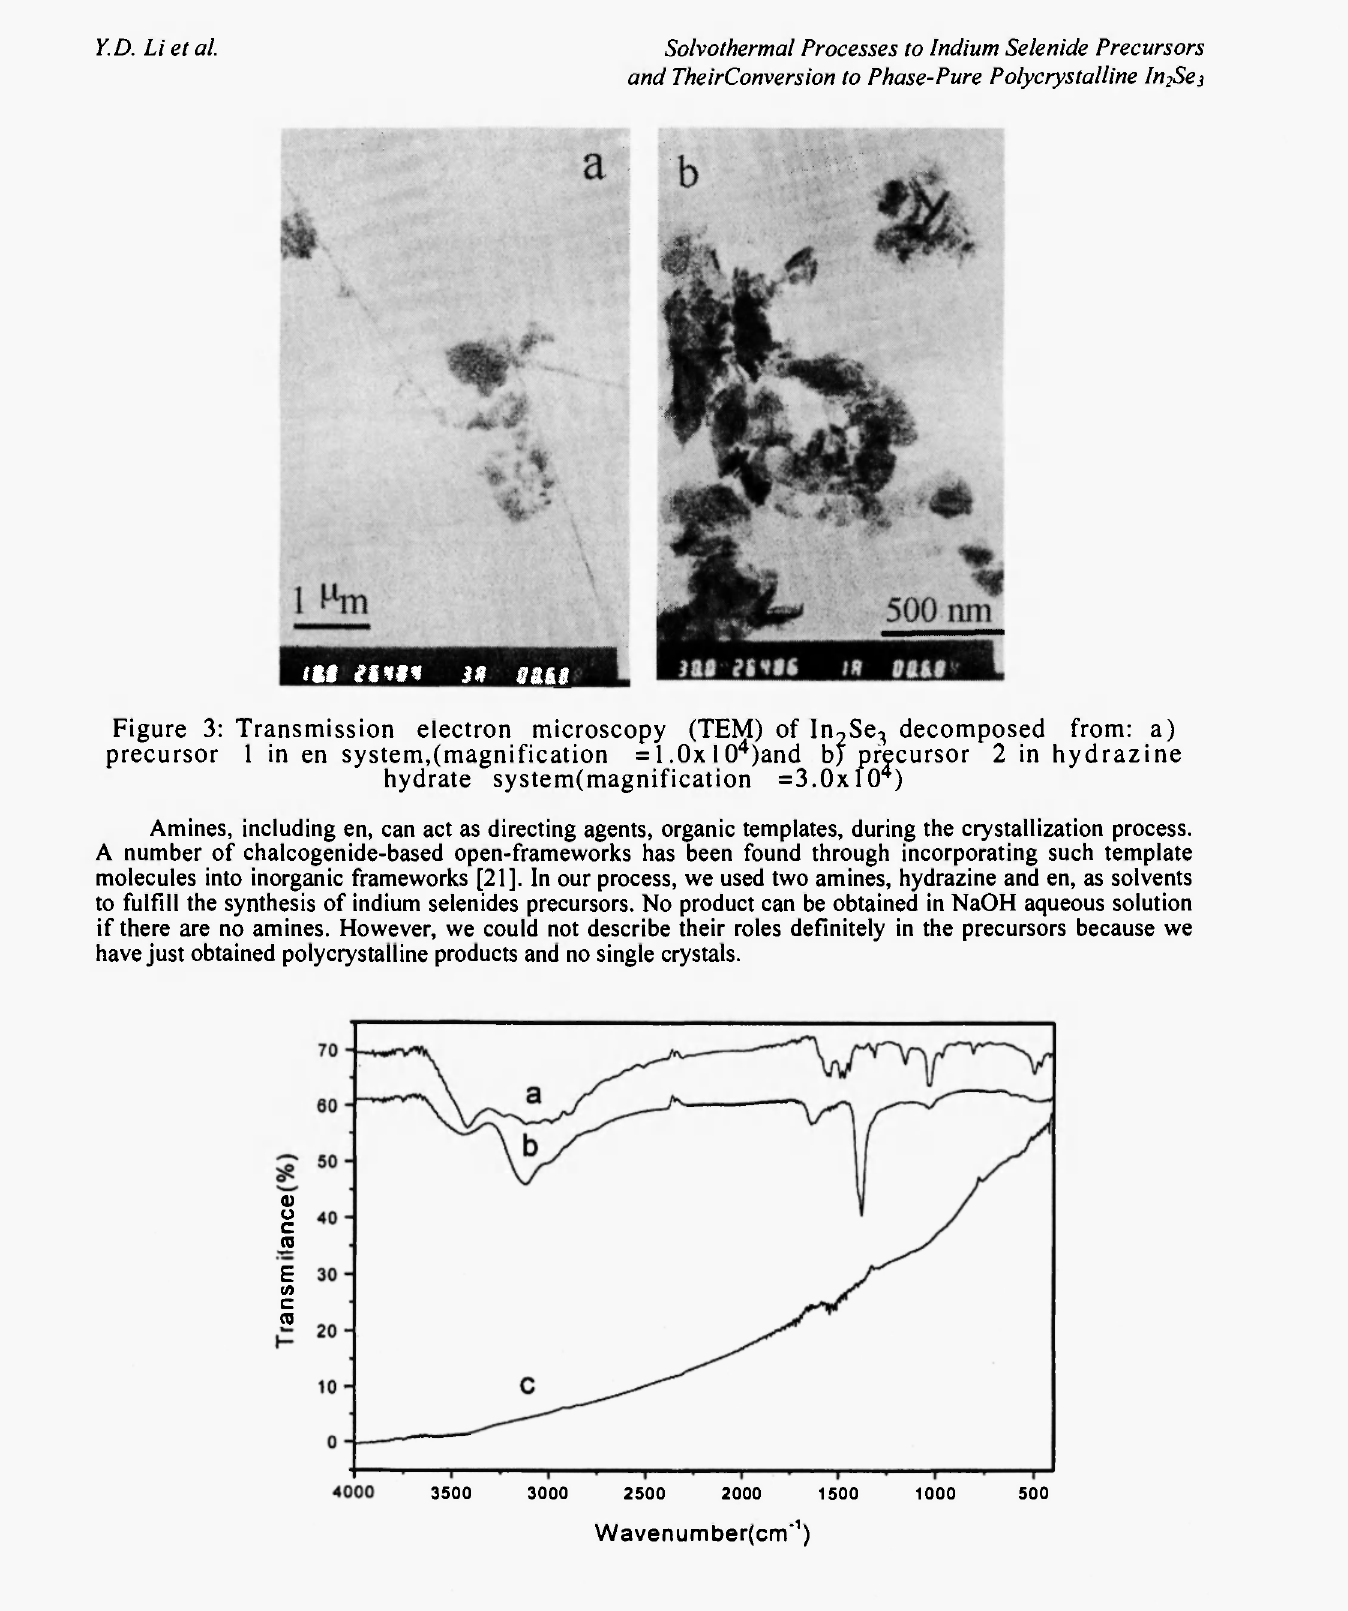
Figure 4: FTIR spectra of: a) precursor 1 obtained in en system, b) precursor 2 obtained in hydrazine hydrate, and c) In 2 Se 3 decomposed from (a) and